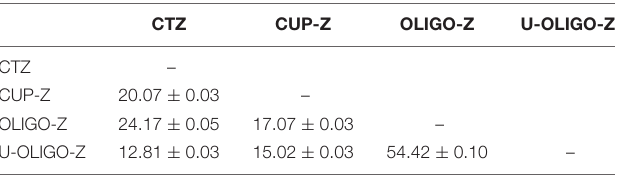
TABLE 6 | Mean ± SE overlap [expressed as a fraction (%) of the non-overlapping area] between estimates of ellipses encompassing 95% of isotope data (all size-classes combined) of the different zones showed in Figure 4 .